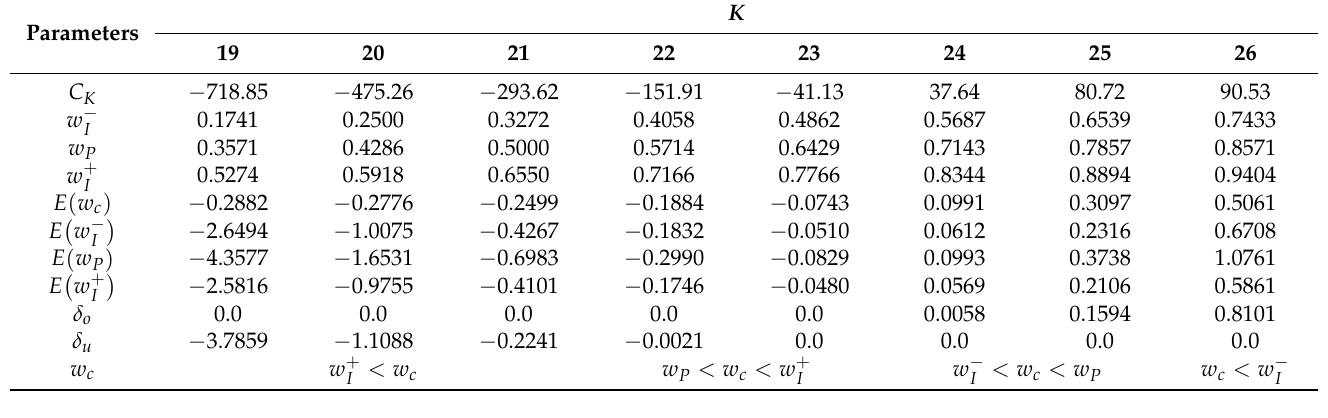
Table 2. Related parameters for Figure 4.